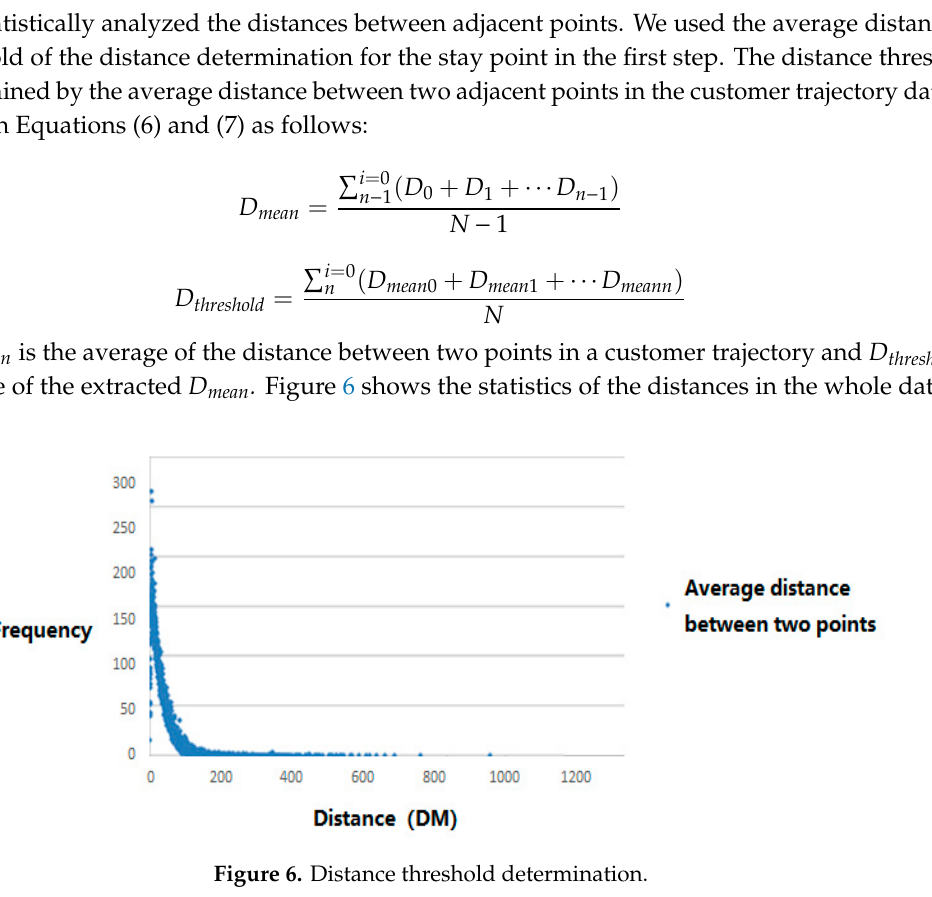
Figure 5. Distance between points.